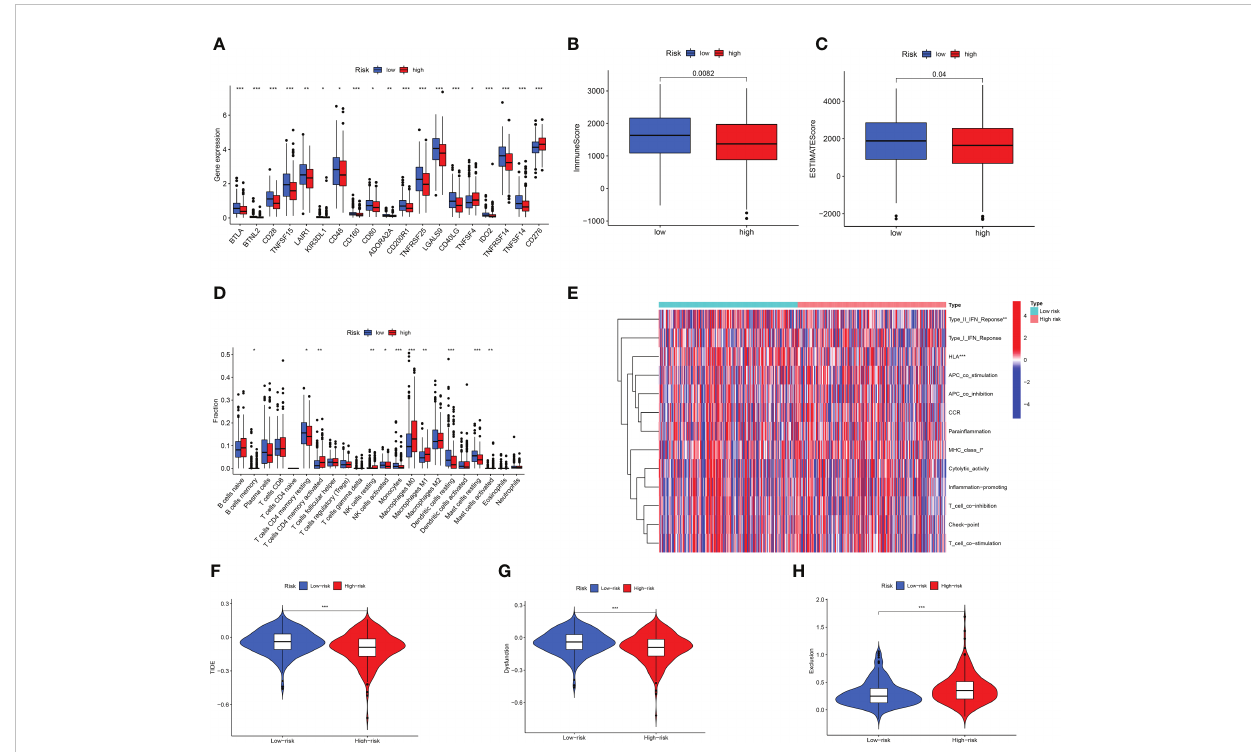
FIGURE 8 Cell in fi ltration in LUAD tumor microenvironment. (A) High-risk compared to low-risk immune checkpoint gene expression. (B, C) Differences in (B) ImmuneScore and (C) StromalScore between two groups. (D) Evaluation of immune cell in fi ltration. (E) Analysis of immune-related functions. (F – H) TME was evaluated based on TIDE for two subgroups. *p < 0.05; **p < 0.01; ***p <